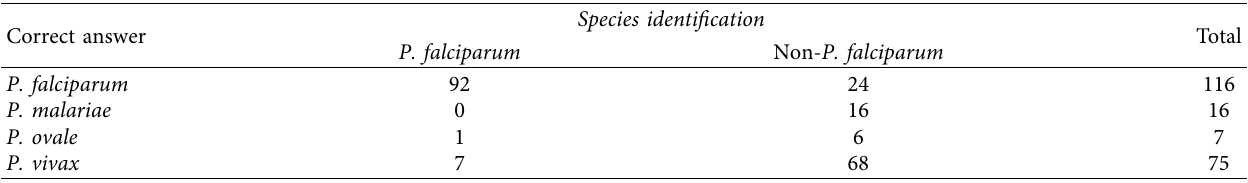
Table 6: Identification of P. falciparum or not among the Plasmodium -positive slides correctly in the qualitative microscopy by repre- sentatives from county CDCs.